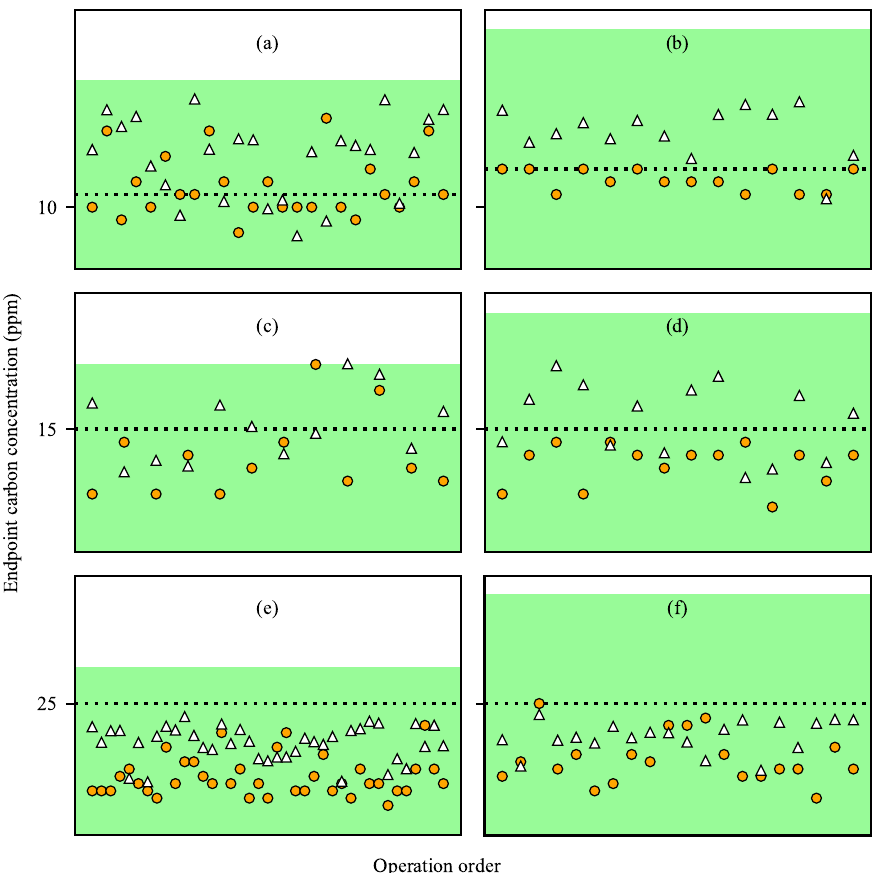
Figure 8. Measured (filled circles) and predicted (empty triangles) carbon concentrations at the end of decarburization by steel types. The target carbon content is: ( a ) 11 ppm, ( b ) 13 ppm, ( c , d ) 15 ppm and ( e , f ) 25 ppm. Areas filled in green indicate acceptable ranges of carbon concentrations and dashed black lines indicate target carbon concentrations. The X-axis of each plot represents the order of operation for each steel